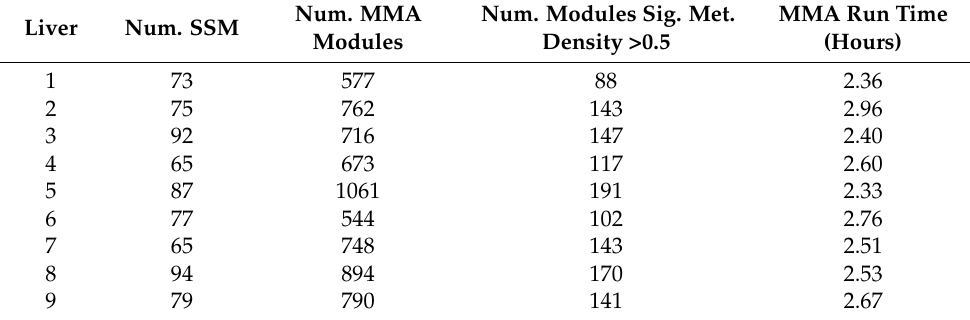
Table 2. For each liver, the details of the MMA partition are provided, including the number of SSMs, the number of modules with at least one SSM, the number of modules with an SSM density greater than 0.5 and the computational time by running Matlab (version 2015a) on one cluster node (c3.8 × large) with 16 workers on Amazon